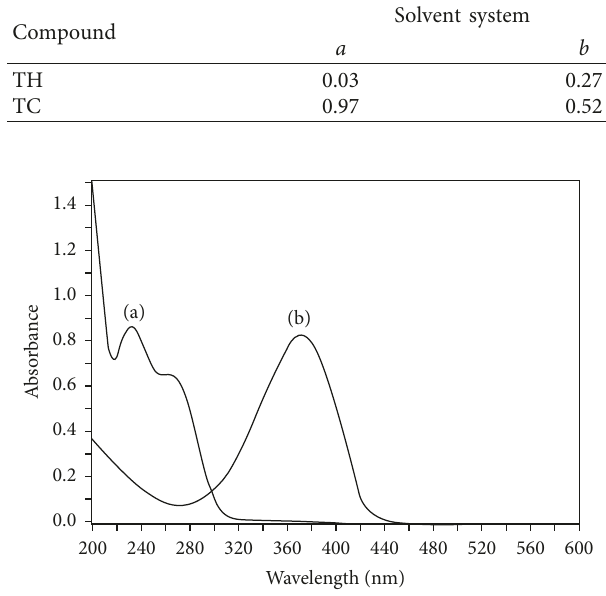
Figure 2: Absorption spectra of (a) thiamine HCl and (b) thio- chrome, at pH 7.0.